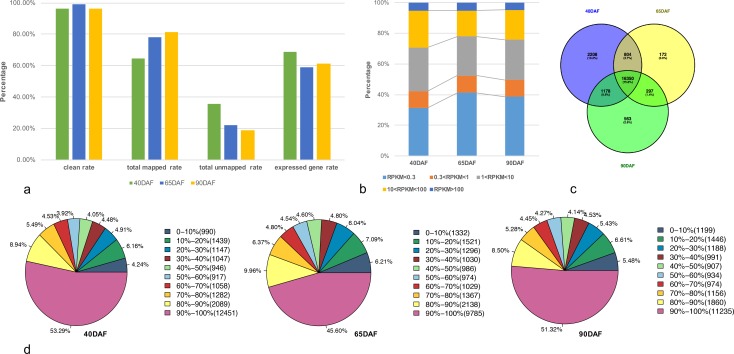
Analysis of global gene expression of RNA-seq data.(a) Summary of RNA-seq reads mapped results in samples (see S1 Table online). The y axis measures the reads or genes mapped percentage. (b) Percentage of genes expressed in samples (see S2 Table online). (c) Venn diagrams showing the number of commonly and uniquely expressed genes among three samples (see S3 Table online). Expressed gene (RPKM > 0.3) in each sample was combined for the analysis. (d) Gene coverage areas in three sample. 40DAF, 65DAF, and 90 DAF were listed as follow. The percentage range are represented by the mapped reads coverage range in each gene. The number in the round brackets are represented the gene number. The percentage are represented the percent of matched genes in the total genes.